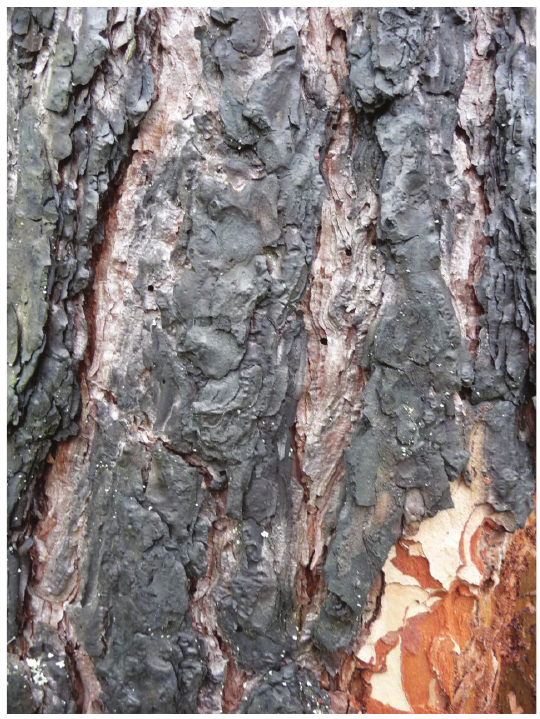
Figure 3. Imago outlets of Stephanopachys linearis (photo by J. Borowski,